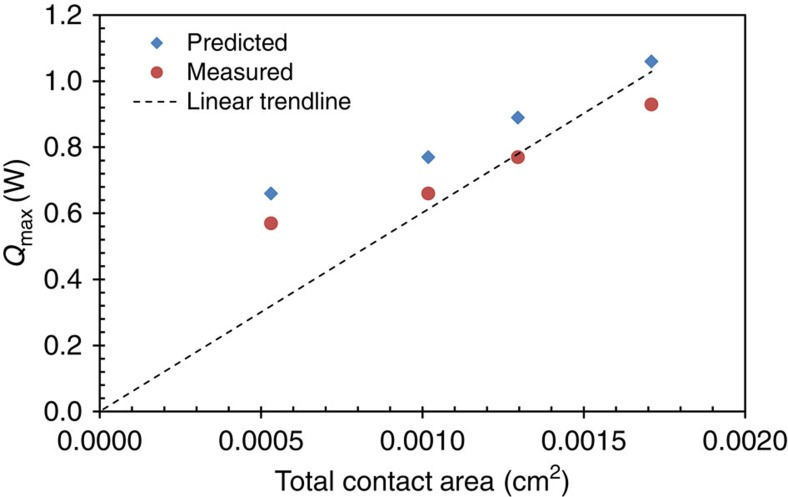
Qmax versus total contact area data for the four thin-film thermoelectric modules of this work.Experimentally measured values are represented by red squares, and the corresponding theoretically predicted values are represented by blue diamonds. The dotted line represents a linear trendline fit to the experimental data. This trendline has been indexed to the origin and is expressed by the equation y=601.6x.